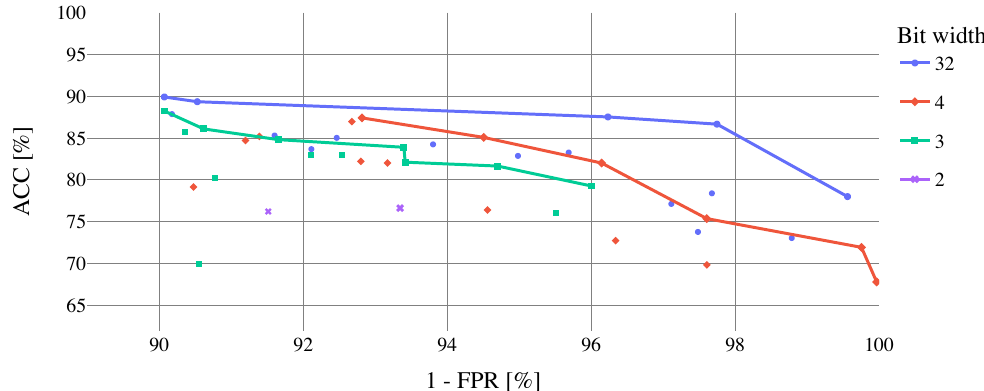
Figure 9. Dependence of model ACC on inverse FPR value (100% ≡ 0% FPR) using full L8-D dataset. Optimal solutions are highlighted by Pareto fronts.